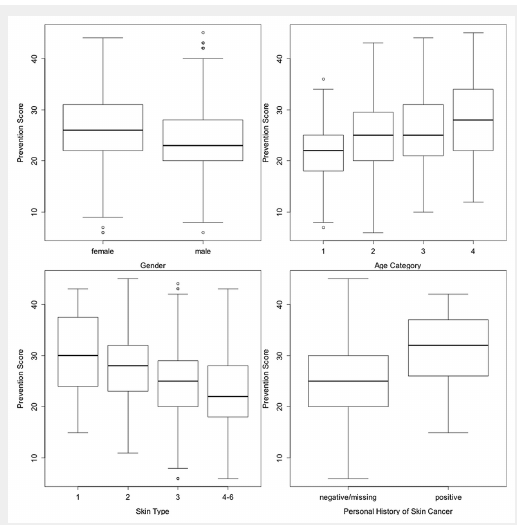
Box plots of the ultraviolet radiation prevention and the skin cancer awareness scores and the educational attainment of the participants, univariate level. The correlation between the UVR prevention score and educational attainment was not significant (p = 0.24). Educational attainment was significantly associated with the awareness score at univariate level only (p = 0.01). 1 is the highest and 4 the lowest educational level. The educational attainment of the participants was grouped into four different subcategories according to the Swiss educational system: (1) university degree, (2) school of applied science, (3) apprenticeship, and (4) basic education.